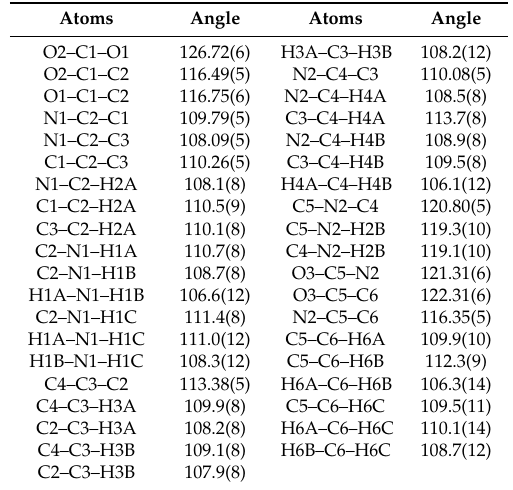
Figure 3. The γ -NADA molecule, obtained from a structure determination at 100 K. Atoms are drawn with anisotropic displacement ellipsoids of the non-hydrogen atoms as well as isotropic ones of the hydrogen atoms at the 80% probability level.